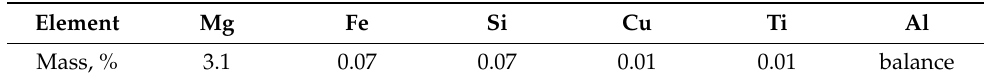
Table 1. Chemical composition of the AlMg3 aluminum alloy (mass, %).